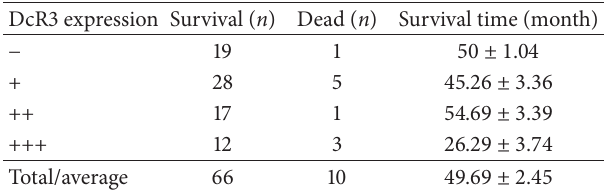
Table 3: Relationship between DcR3 expression and survival (𝑥±𝑠) . DcR3 expression Survival ( n ) Dead ( n ) Survival time